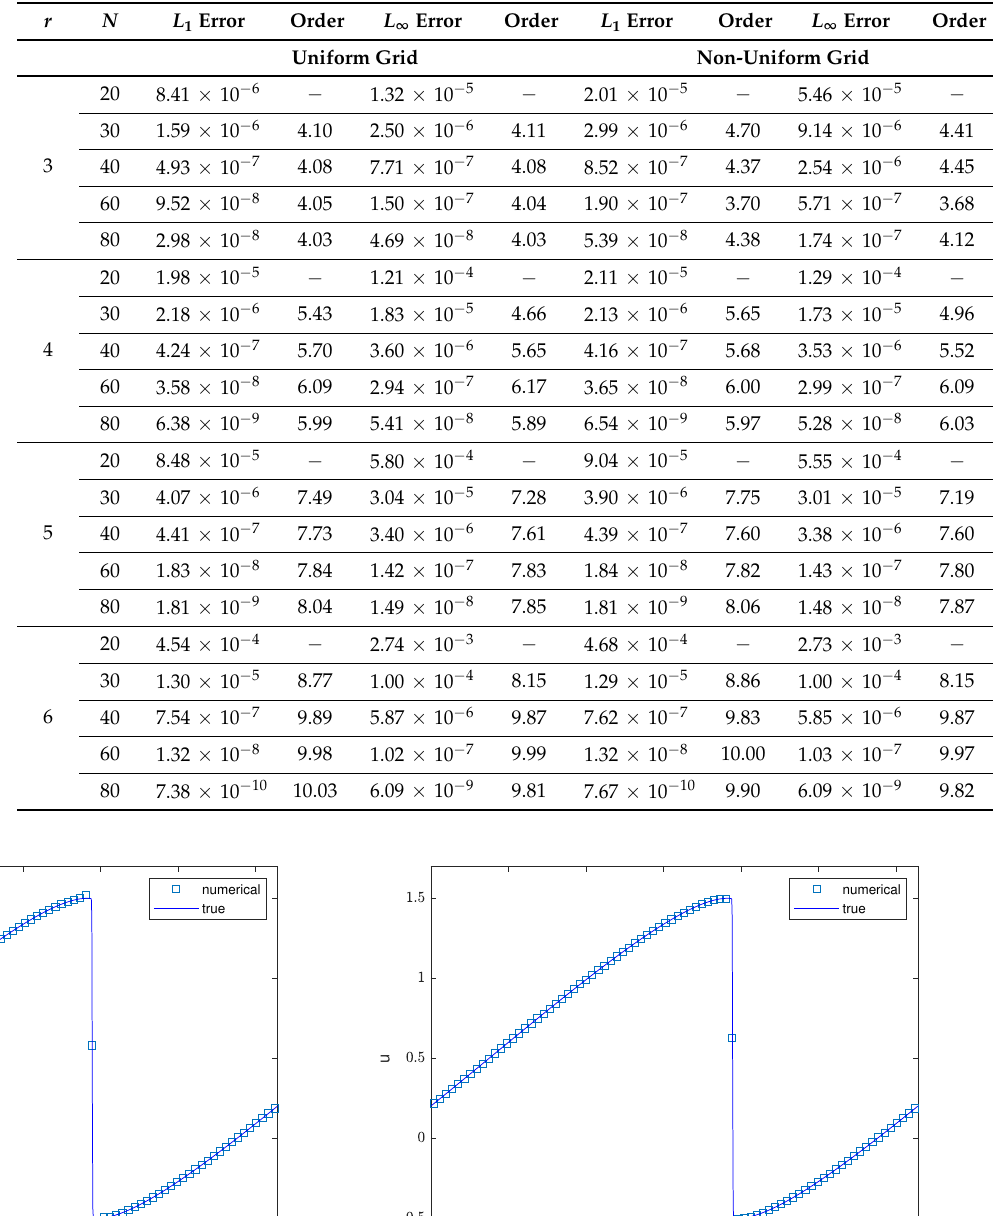
Table 2. Accuracy test for Burgers equation with u ( x ,0 ) = 0.5 + sin ( x ) at t = 0.5.